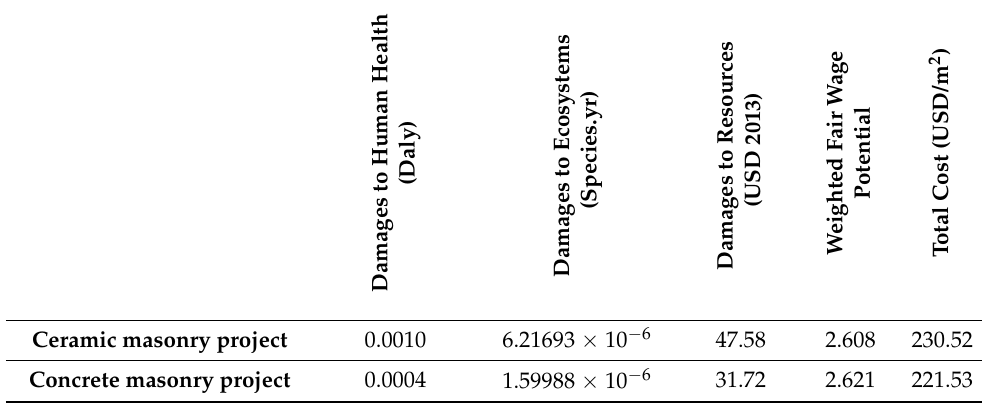
Table 13. Individualist perspective: values of the criteria for determining sustainability.